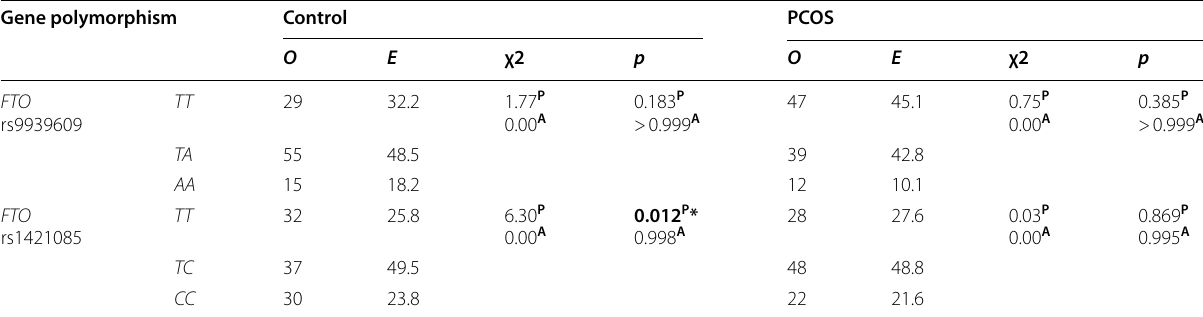
Table 2 Observed and expected values of FTO rs9939609 (T>A) and FTO rs1421085 (T>C) variants in PCOS patients and controls by Hardy–Weinberg equilibrium